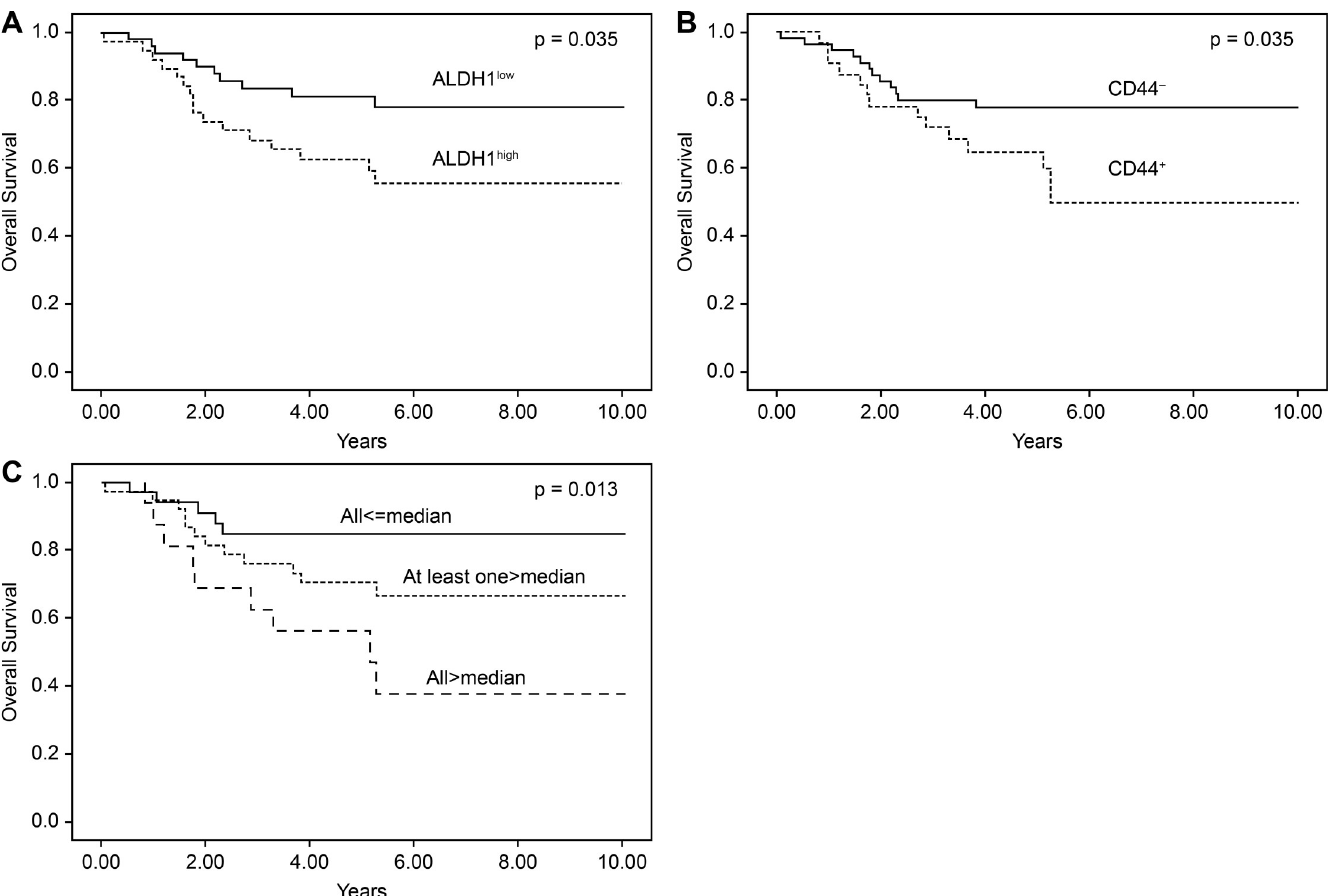
Fig 3. Kaplan–Meier analysis of survival in patients with EC based on ALDH1 and CD44 protein immunostaining. Patients with a higher ALDH1 (A), CD44 (B), combine ALDH1 and CD44 (C) immunostaining score had poor overall survival compared with those with a lower immunostaining score in patients with EC.